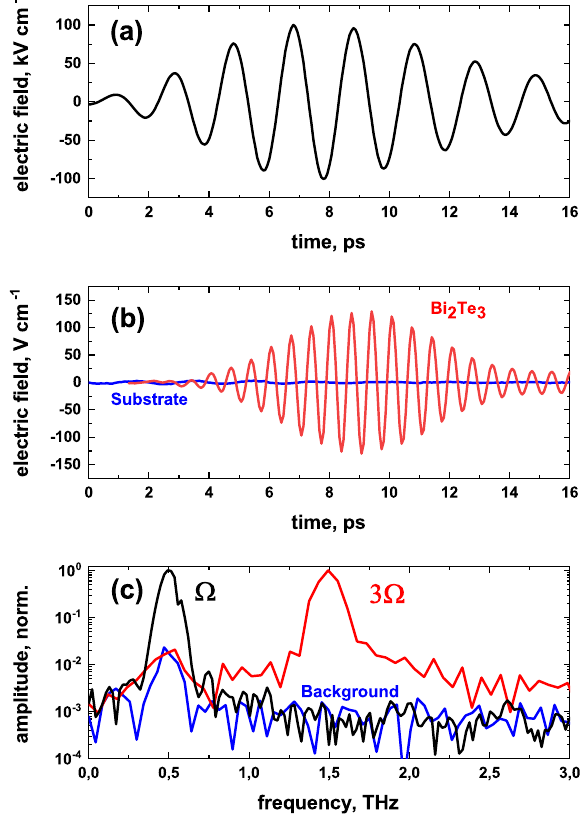
Fig. 2 THz third-harmonic generation in Bi 2 Te 3 . Time-domain waveforms of the fundamental radiation electric fi eld ( a ) and the third-harmonic fi eld generated in Bi 2 Te 3 , and the Al 2 O 3 substrate for reference ( b ). Amplitude spectra of the fundamental radiation and THG in Bi 2 Te 3 and substrate ( c